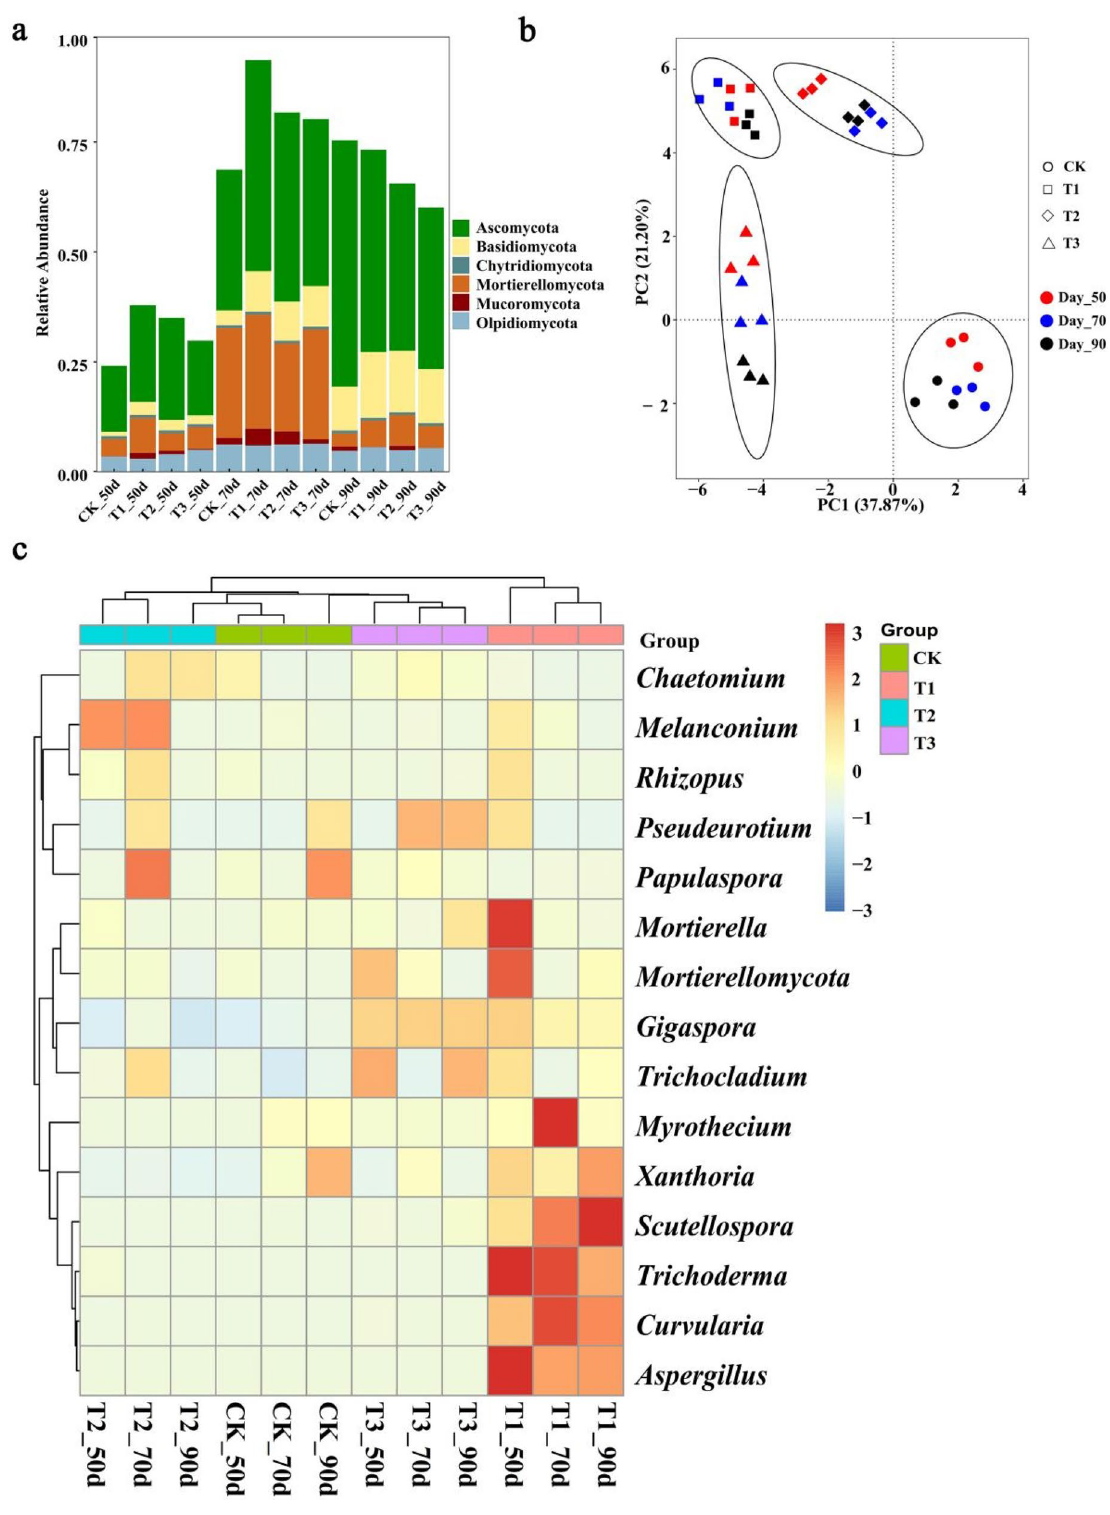
Figure 2. Soil fungal community in four treatments at 50 d, 70d and 90 d post-transplanted, respectively. (a) The relative abundance of fungal phyla in soil samples. (b) Hierarchical cluster analysis of predominant fungal genera. (c) The Principal components analyzed (PCA) of soil fungal community. (CK: the control group, T1: marigold powder mix with B. amyloliquefaciens ZM9 group, T2: B. amyloliquefaciens ZM9 group, T3: marigold